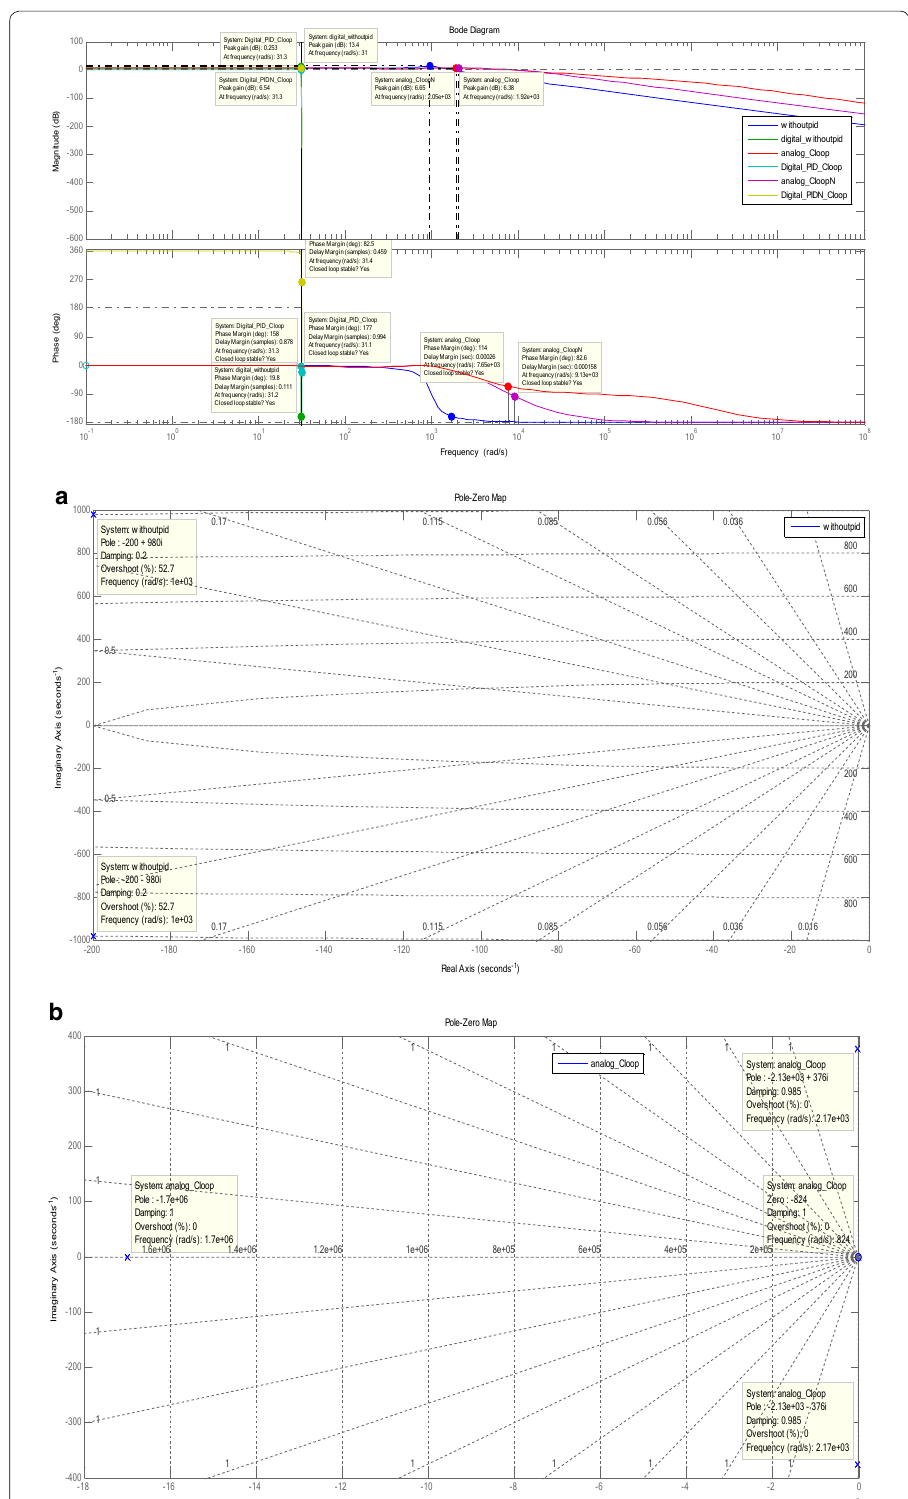
Fig. 11 Mixed domain frequency response of BBC in boost mode in open loop and closed loop with PID and PIDN. a – c Analog domain—pole-zero plot of BBC in boost mode in open loop ( a ), closed loop with PID ( b ) and PIDN ( c , d ). Digital domain pole-zero plot ( Z -plane) of BBC in boost mode in open loop and closed loop with PID and